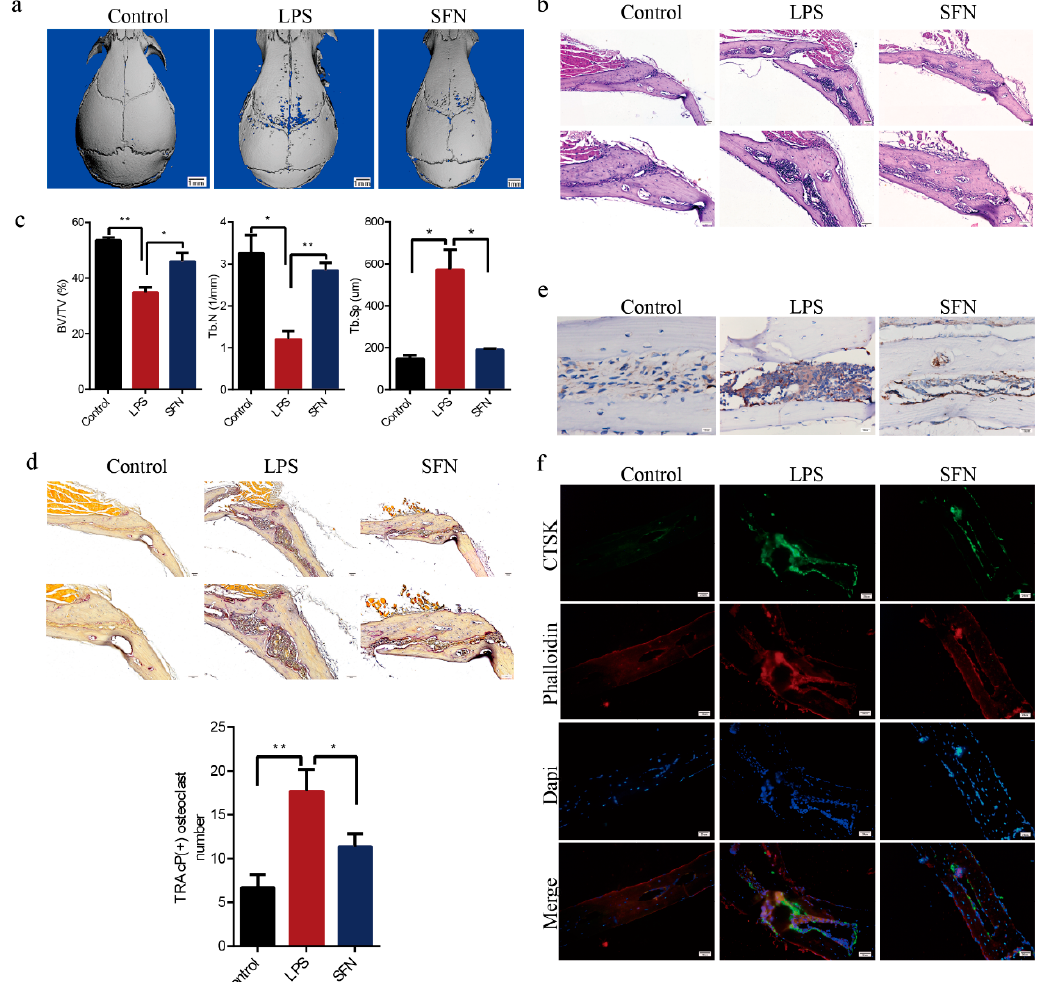
Figure 5. SFN protected against lipopolysaccharide (LPS)-induced calvarial bone destruction in mice. ( a ) Micro computed-tomography (CT) 3D reconstructed images. Calvarias were fixed, decalcified, dehydrated, embedded, and sectioned. ( b ) Representative hematoxylin-and-eosin (HE) staining images. ( c ) Microarchitectural parameter analysis: trabecular bone volume/total volume (BV/TV), trabecular number (Tb.N), and trabecular separation (Tb.Sp). ( d ) Representative tartrate-resistant acid phosphatase (TRAP) staining images showing osteoclastogenesis in each sample and corresponding statistics. ( e ) Representative IHC images locating CTSK. ( f ) Representative IF images of the distribution of CTSK (green). Phalloidin (red) indicates cytoskeleton and bone. DAPI (blue) was used to counterstain the nuclei. Values are mean ± SEM of three independent experiments; * p < 0.05, ** p < 0.01.